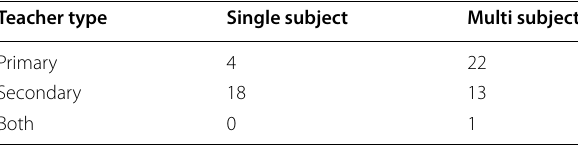
Table 1 Teachers’ reported type of credentialing by teacher